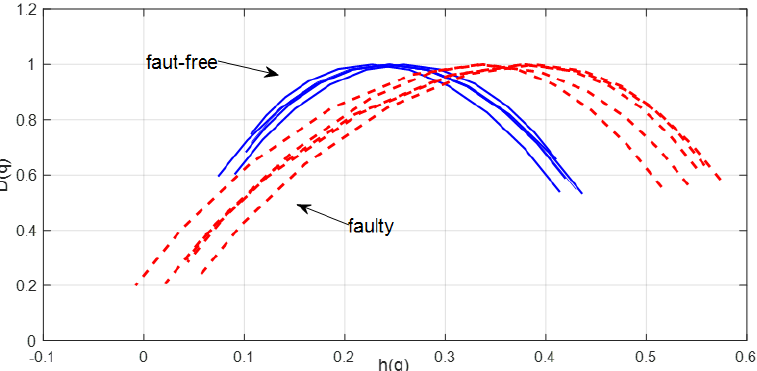
Figure 10. Statistical features of the vibration signal for fault-free and faulty conditions at rotational speed of 2000 rpm and load of 30 Nm.